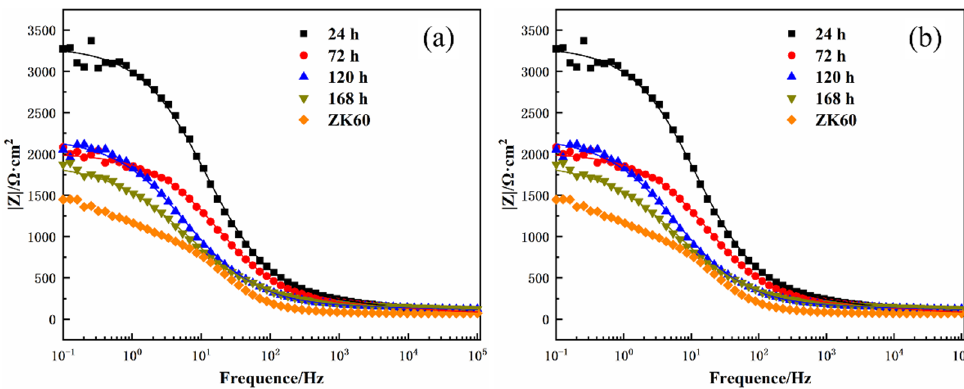
Figure 11. EIS spectra of ZK60 and 12 h samples at different immersion times: ( a ) Bode plots; ( b ) phase plots.